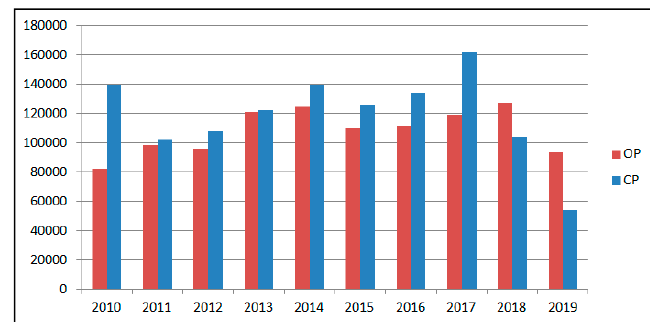
Figure 2. Number of CP and OP (for construction) by years in Turkey.